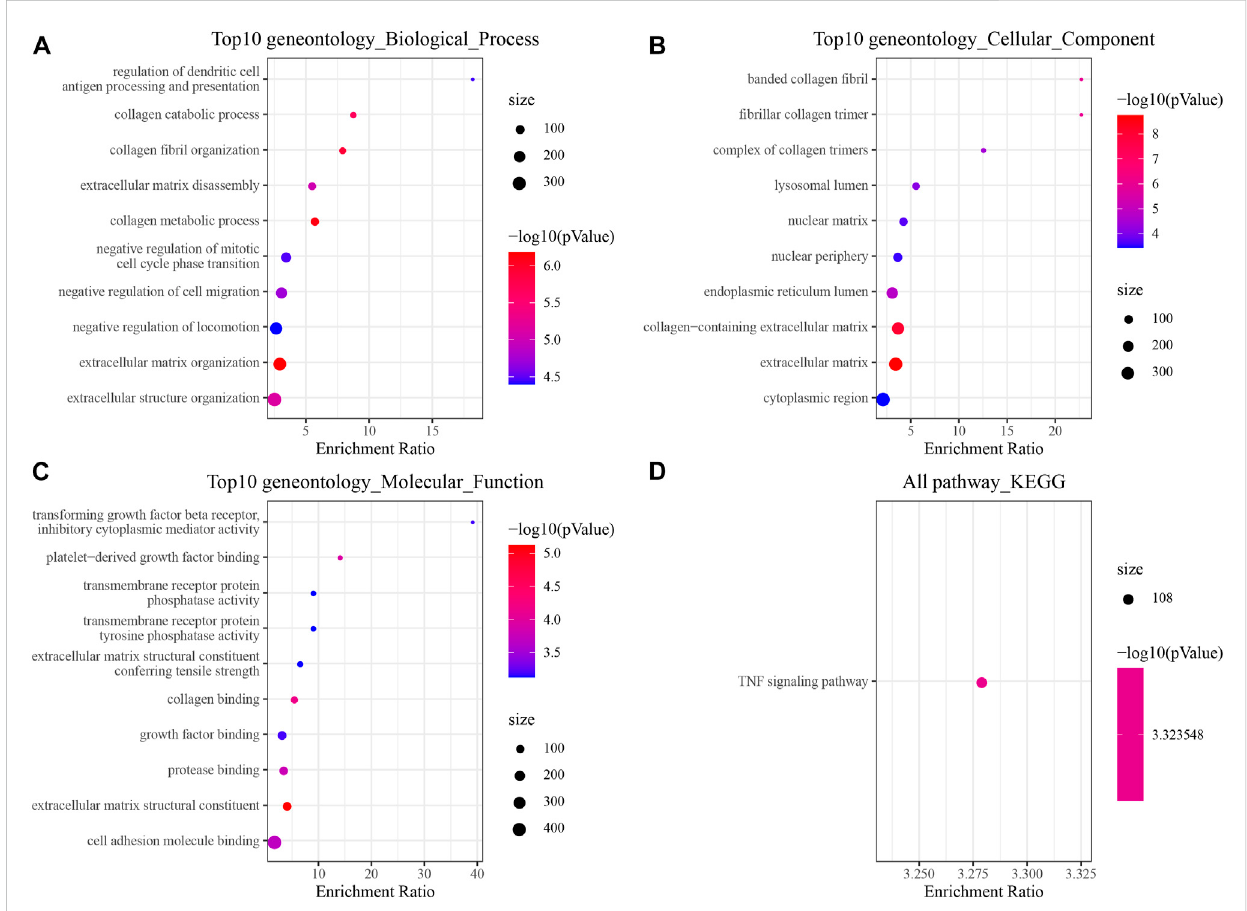
FIGURE 1 Changes in the transcriptome of brain metastases in NSCLC [GSE200563]. (A) Top 10 Gene Ontology (GO) terms at the biological process level. (B) Top 10 GO terms at the cellular component level. (C) Top 10 GO terms at the molecular function level. (D) Signi fi cantly enriched Kyoto Encyclopedia of Genes and Genomes (KEGG)